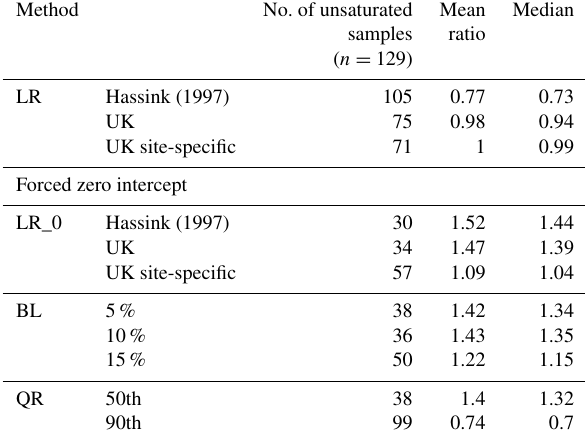
Table 4. Carbon saturation ratios calculated from the estimated maximum fine-fraction organic carbon by linear regression (LR), linear regression with a forced zero intercept (LR_0), boundary line (BL) and quantile regression (QR). Values < 1 indicate unsaturated samples; 1 indicates saturation; and values > 1 indicate oversatu- rated